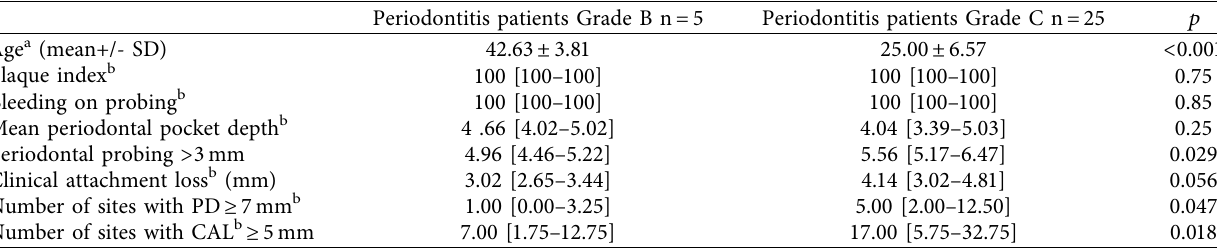
Table 3: Periodontal clinical parameters in the periodontitis group.